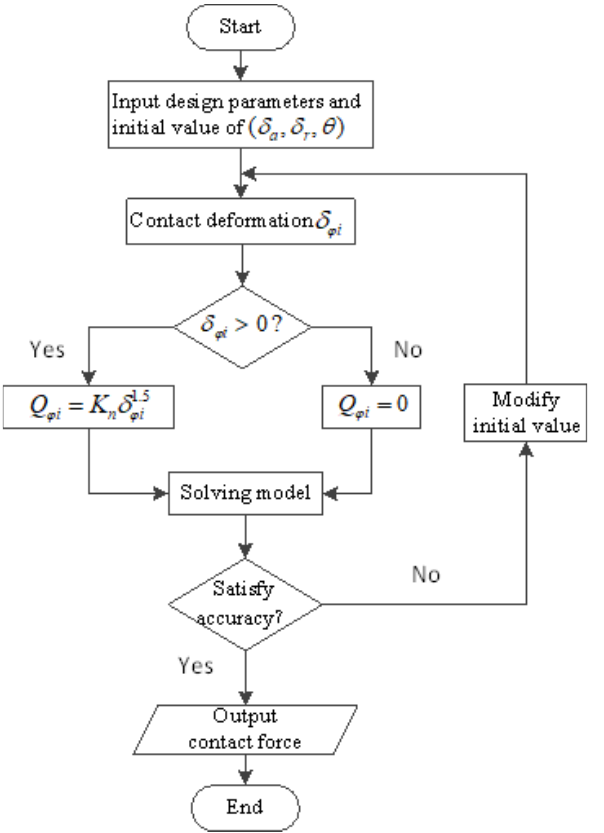
Figure 3: Calculation flowchart of load distribution with rigid ring